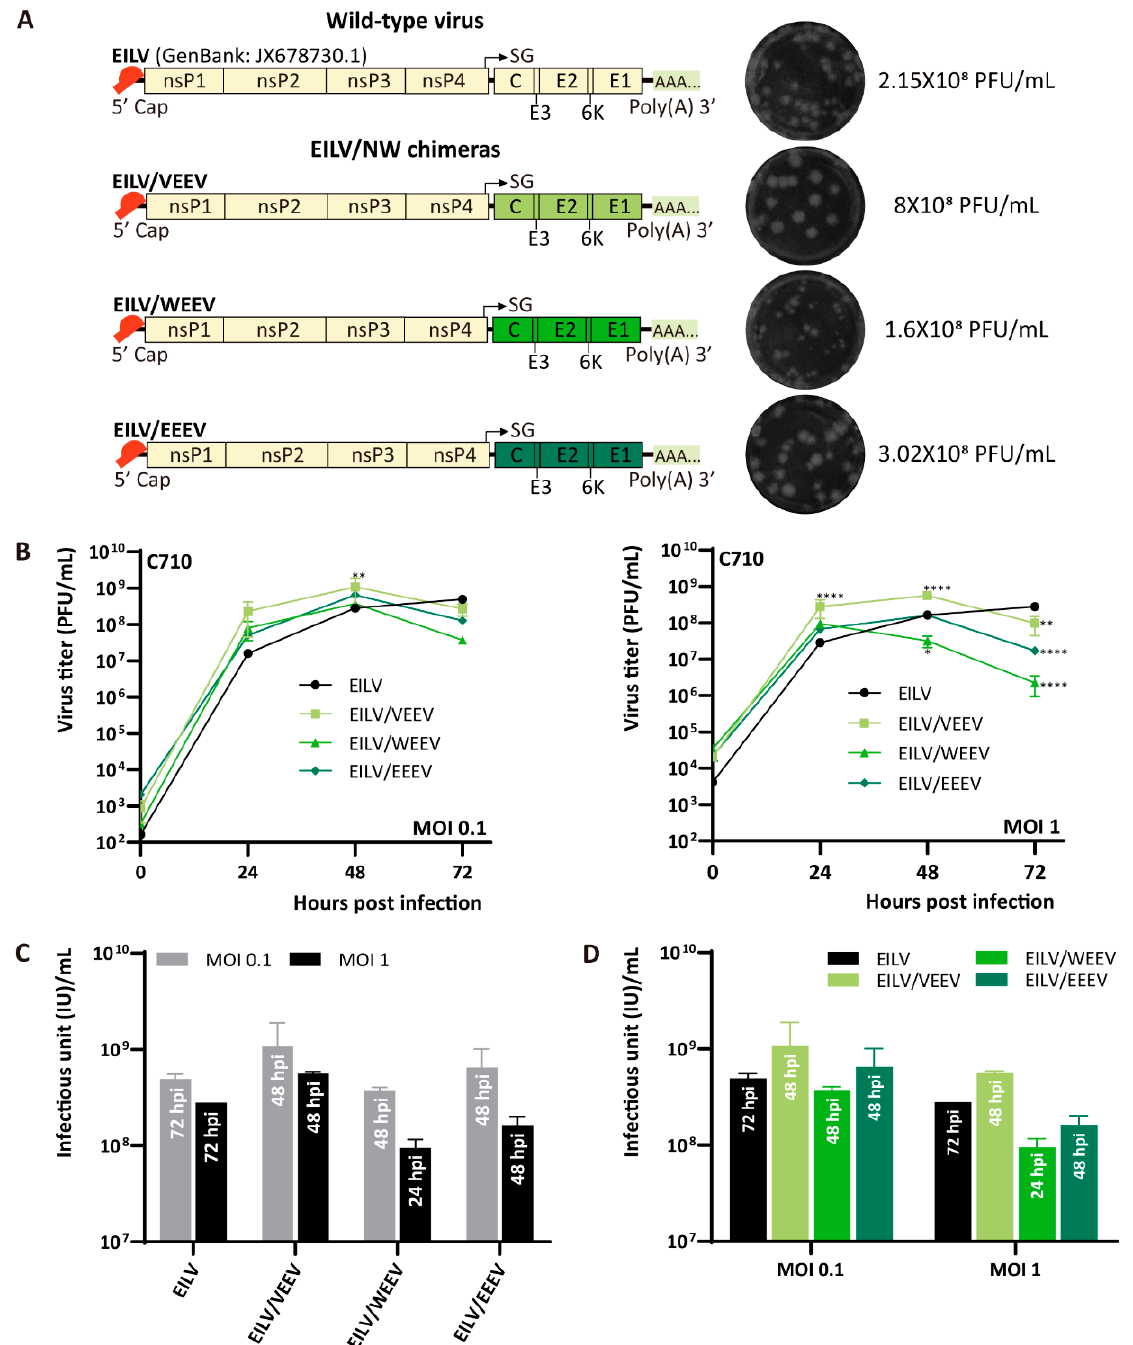
Figure 2. Genome organization and replication kinetics of EILV/ New World (NW) chimeras. ( A ) Genome organization of EILV/NW chimeras. Viruses were rescued on C7/10 cells and harvested at 2 dpe. Rescue titers and plaque phenotypes are displayed. ( B ) Replication of EILV/NW chimeras in C7/10 cells. Cells were infected at an MOI of 0.1 or 1. Media were collected at the indicated time points post-infection, and titers were determined by plaque assay. ( C ) The optimal titers obtained by each virus with different MOIs. ( D ) Comparison of the optimal titers produced by EILV and EILV/OW chimeras. The annotation embedded in each bar in ( C ) and ( D ) indicates the time point of reaching the highest titer. Each sample was titrated twice ( n = 2). Average titers ±SD (error bars) are shown. **, p < 0.01; ****, p < 0.0001.